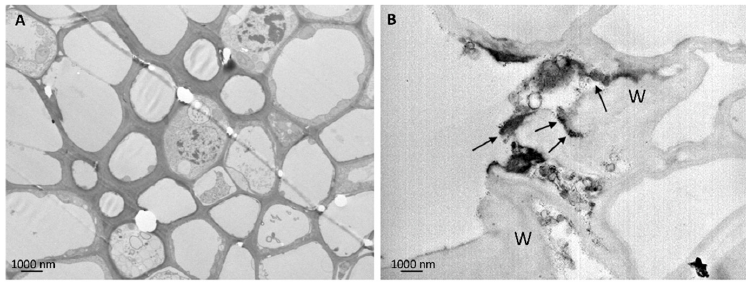
Figure 5. Representative TEM micrographs from secondary vein tissues of barley plants. ( A ) Control untreated vein tissues appear well structured, cell walls are regular in shape and thickness; ( B ) Ti 1000: secondary veins showed cells with contorted cell walls (W) associated with little dark precipitates